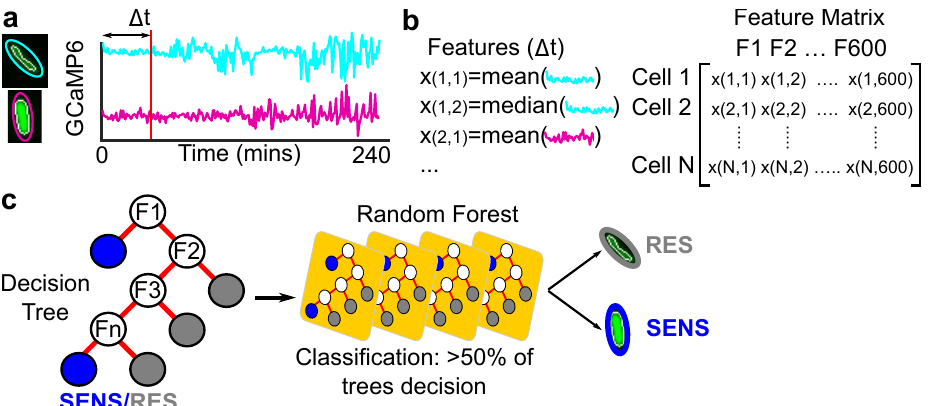
Figure 2. Machine learning schematic to measure how Ca 2 + dynamics distinguish sensitive and resistant cells at single-cell resolution. ( a ) For each cell’s Ca 2 + trace, summary statistics are calculated. ( b ) Features are different summary statistics (i.e., moments) of the Ca 2 + trace with different smoothing functions and normalization protocols resulting in 600 total features, (see Supplementary Materials section Feature calculation from fluorescent traces ). We define a value ∆ t corresponding to the length of the trace to subset before calculating the features. Calculating these features for a particular ∆ t for all cells results in a feature matrix. The feature matrix is used to train a random forest classifier to distinguish sensitive and resistant cells. ( c ) The random forest is comprised of decision trees ( left ), which make a binary classification for each cell based on the calculated trace features (Fn). Many decision trees are combined to create a random forest, which makes a final classification by weighting the decision from all the trees. As ∆ t increases, more of the Ca 2 + trace is included, improving the classifier’s discriminative capacity. Therefore, the random forest acts as a stopwatch for how early the sensitive and resistant cells can be reliably